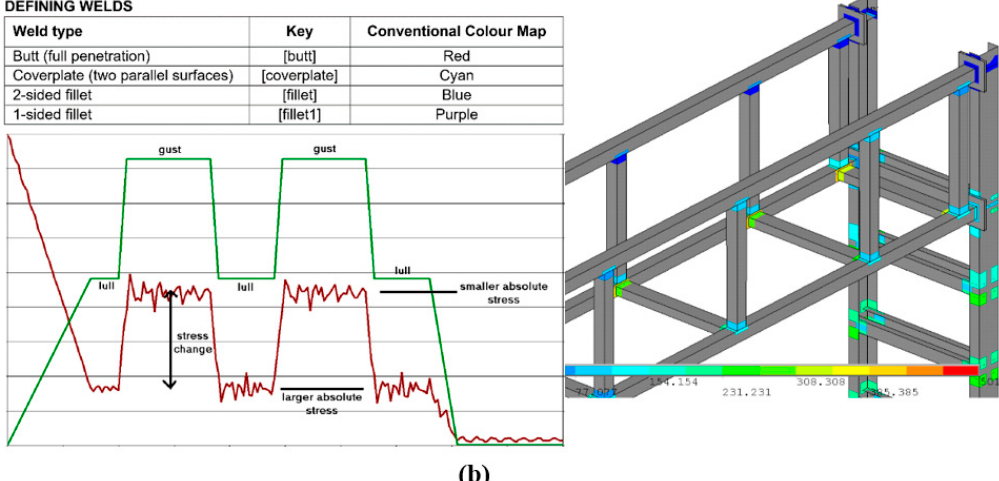
Figure 16. ( a ) Fatigue damage alternative mathematical representation for detailed stress cycles; ( b ) transient gust pressure loading pattern with structural response and results of graphical postprocessing tool [48].